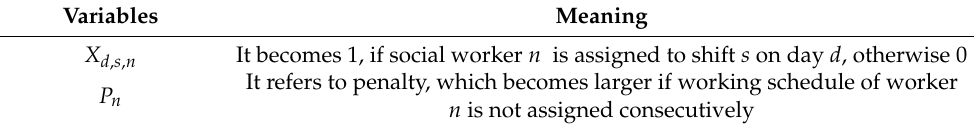
Gap between maximum and minimum number of night shifts by workers Table 2. Decision